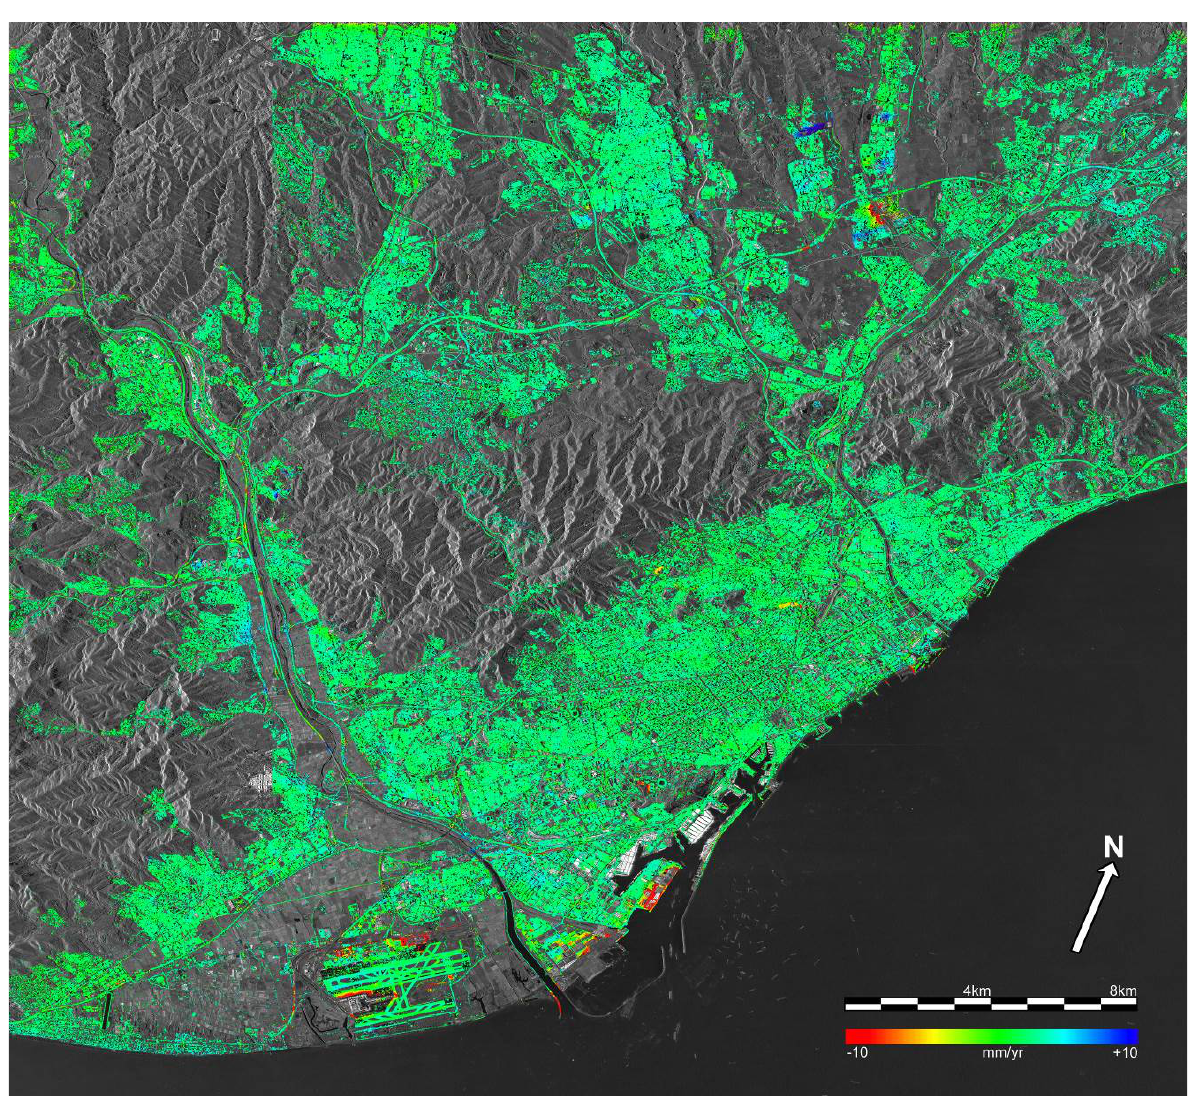
Figure 1: Deformation velocity map of the Barcelona dataset superposed to a mean SAR amplitude image. The map includes more than 5.4 million PSs and covers 1019 km 2 . It was derived using 28 very high-resolution TerraSAR-X images that span the period from December 2007 to November